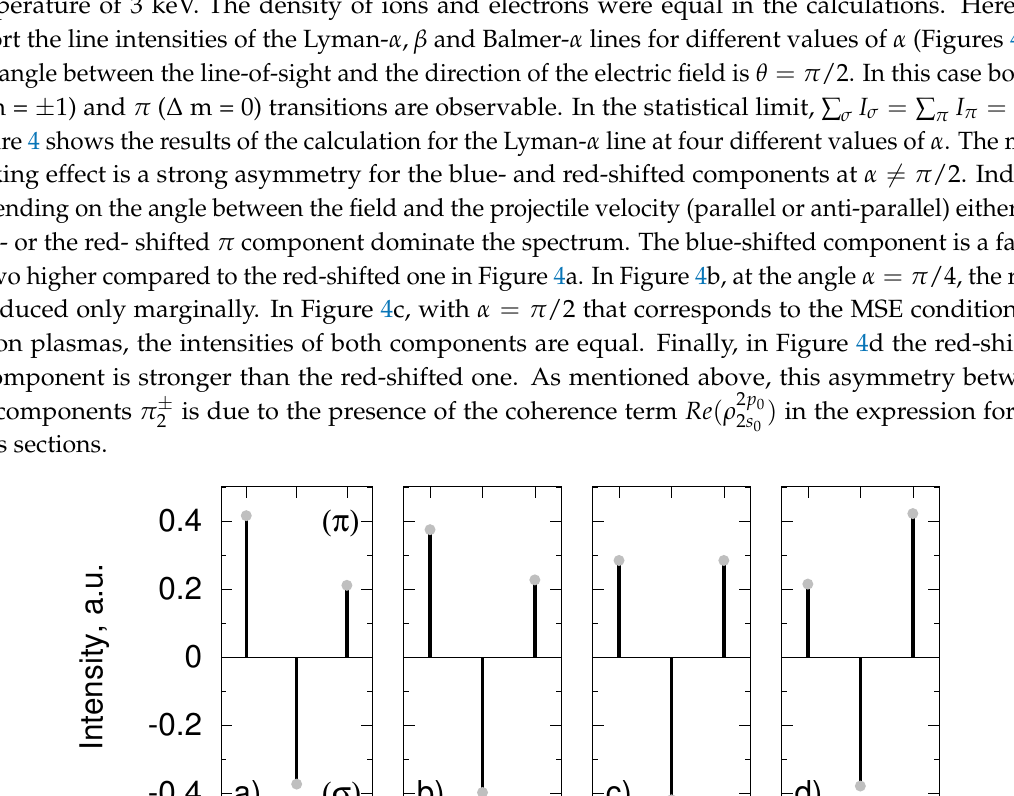
, where ¯ h is 8 π 2 m e ec